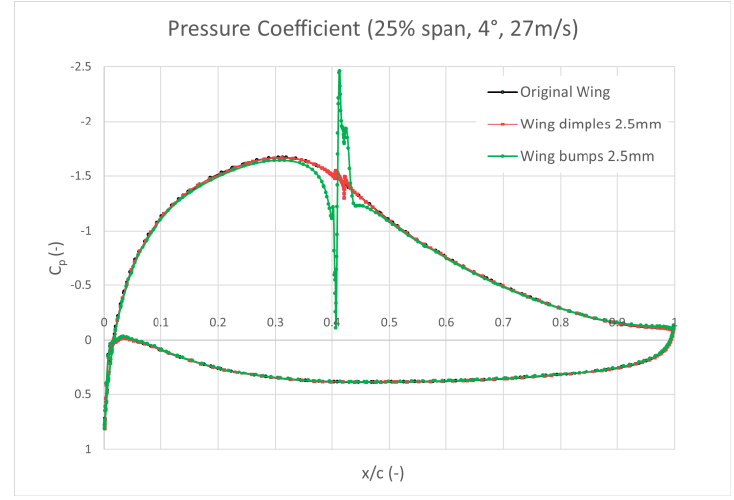
Figure 17. Pressure coefficient distribution around the airfoils at 25% of the wingspan, 4° AoA and Re = 258,000, of the three wings. Table 7. Experimental lift and drag coefficients for each wing